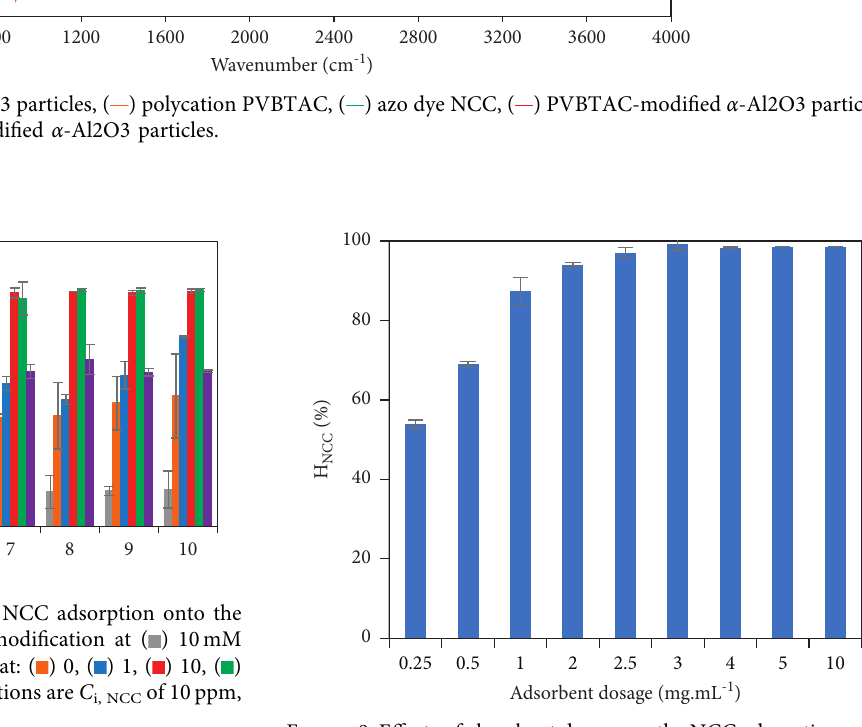
Figure 8: Effects of absorbent dosage on the NCC adsorption onto the PVBTAC-modified α -Al 2 O 3 particles with C i ,NCC of 10ppm, − 1 pH 8, NaCl 10mM, t of 2h, and m α -Al2O3 of 3mg mL